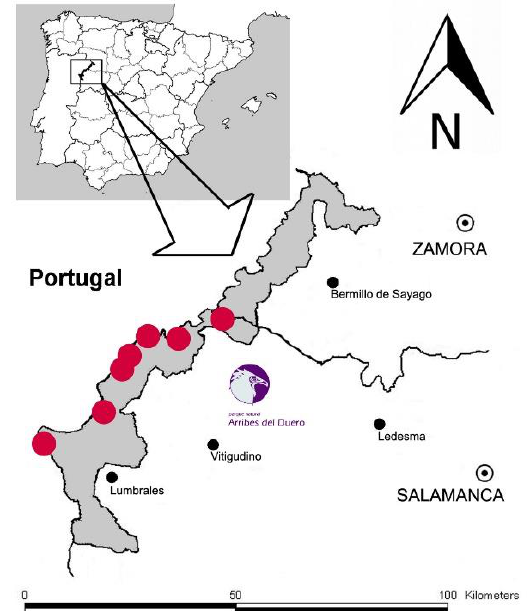
Figure 1. Geographic location of the Arribes del Duero Natural Park and the seven known popula- tions in this protected area for the plant that is the subject of our study and conservation (red dots).